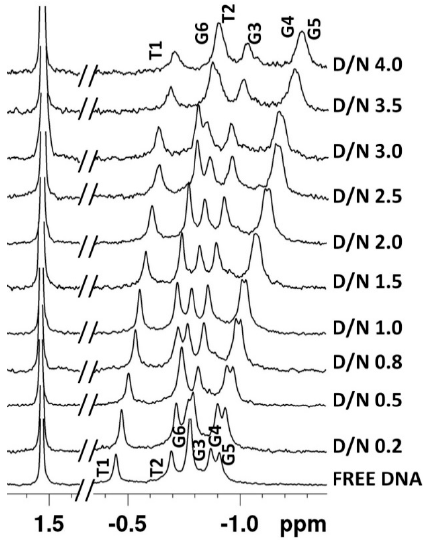
Figure 5. Proton decoupled 31 P NMR spectra of 1.16 mM [d-(TTGGGGT)] 4 and its complex upon the progressive addition of daunomycin at different D/N ratios in 10 mM of phosphate buffer with 100 mM of KCl (90% H 2 O + 10% D 2 O) at 25